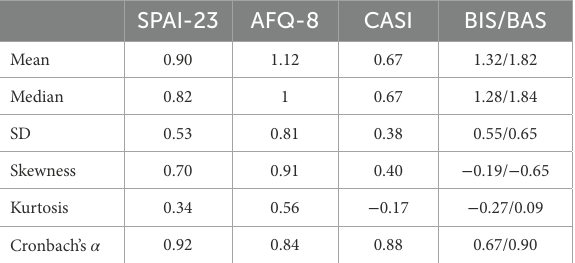
TABLE 1 Descriptives and Cronbach’s alphas for each scale with the current